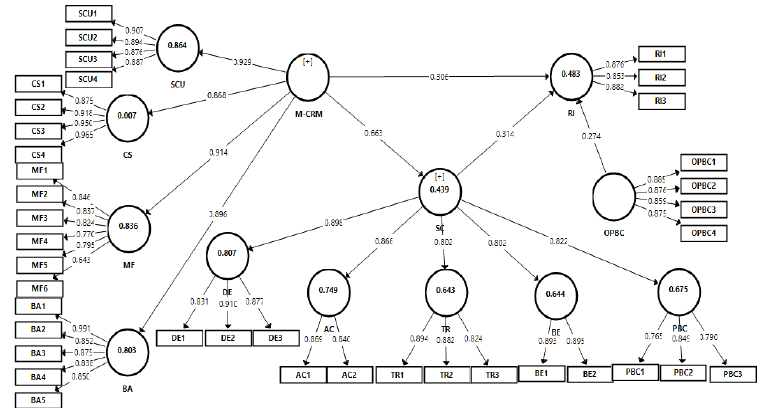
Fig. 2. The Measurement Model